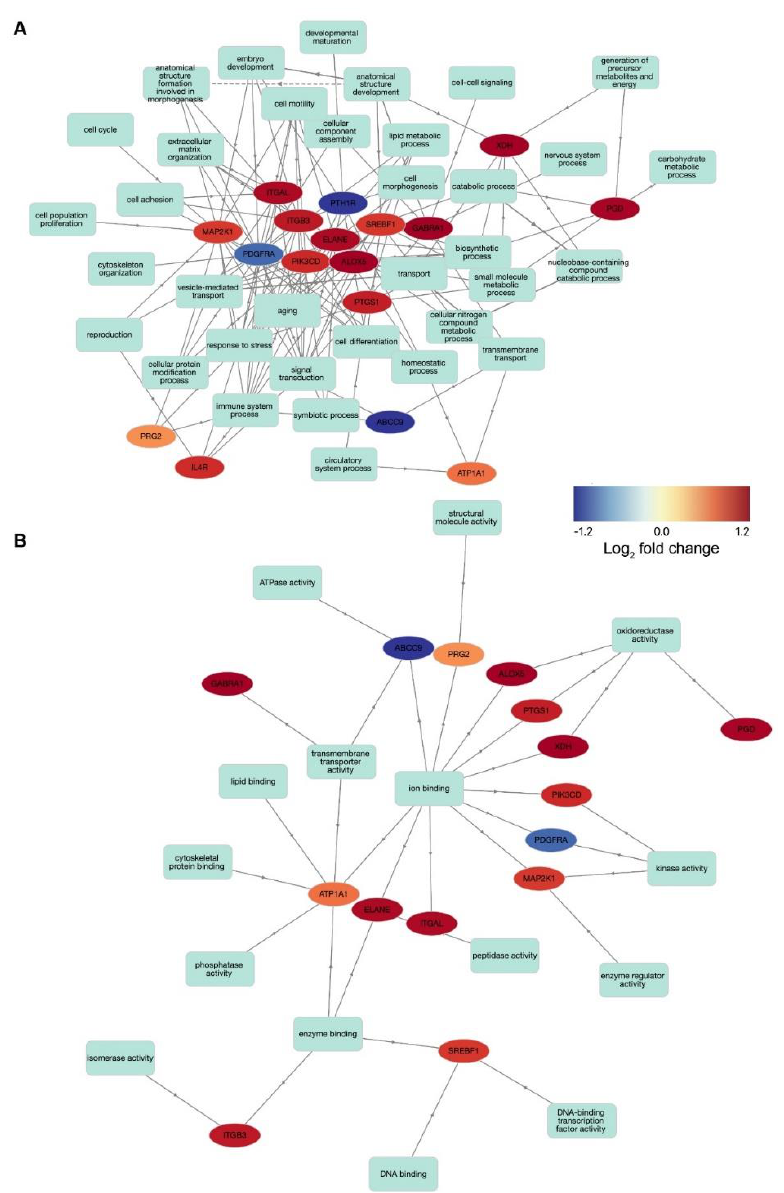
Figure 5. Potential drug targets link several biological pathways and functional mechanisms Network analyses identifying the interactions between the differentially expressed gene (DEG) products (drug targets) involved in ( A ) biological processes and ( B ) molecular functions using gene ontologies containing a subset of the terms (i.e., GOslim). The color map represents the log 2 fold change values with ageing. Unconnected DEGs are not